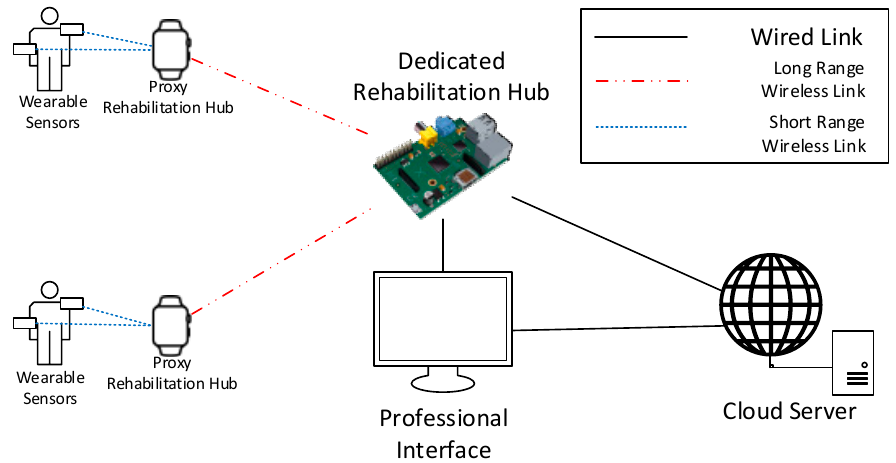
Figure 6. Example of deployment for the outdoor activities use case.